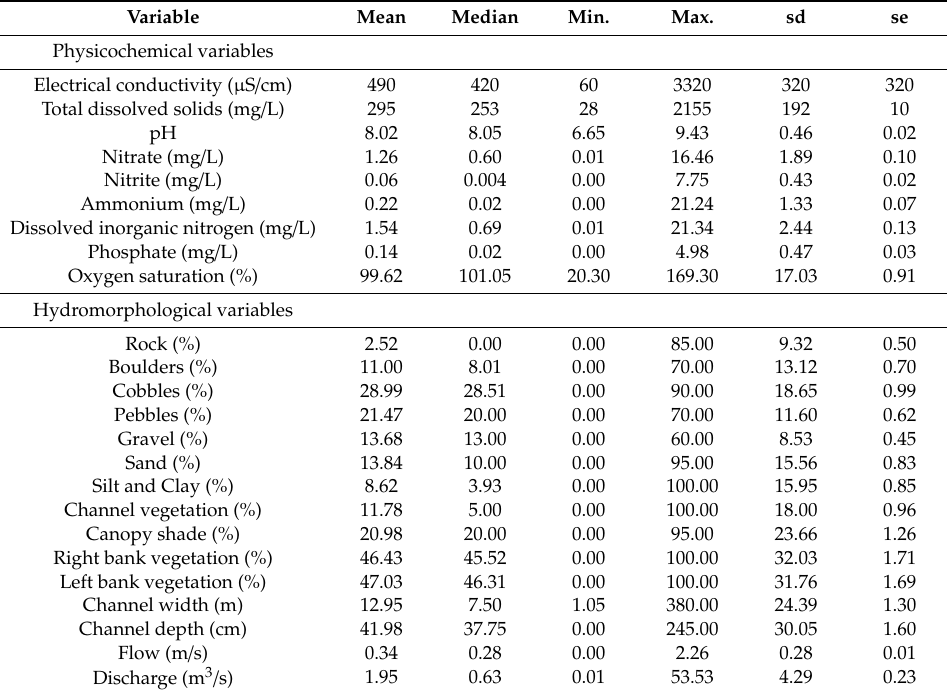
Table 2. Descriptive statistics of water quality and hydromorphological variables aggregated at river site. (sd means standard deviation and se means standard error of